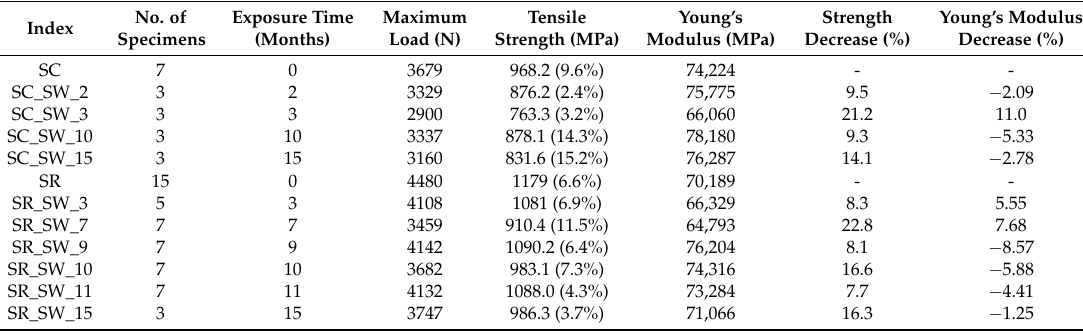
Figure 12. Comparison between SR and SR_W_5. Table 5. Test results for GFRP specimens subjected to ageing treatment (NaCl solution).